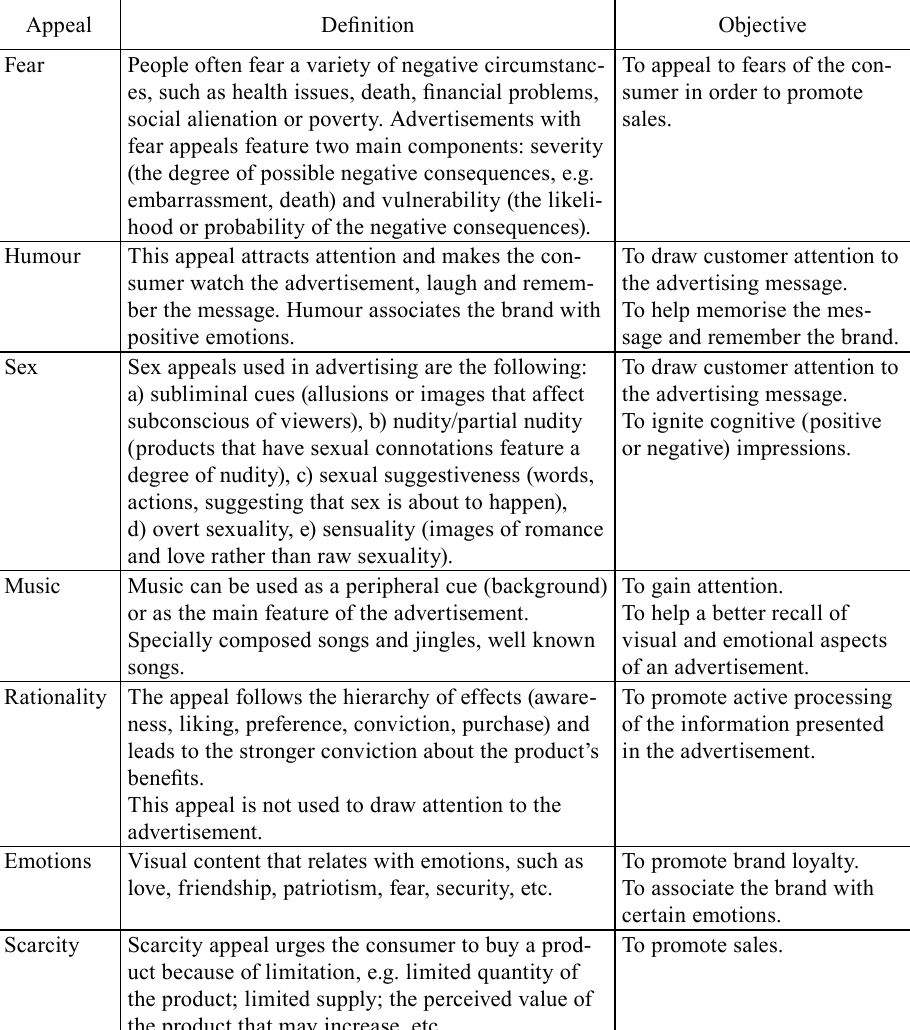
table 1. Definitions of advertising appeals and their objectives (according to Clow and Baack).